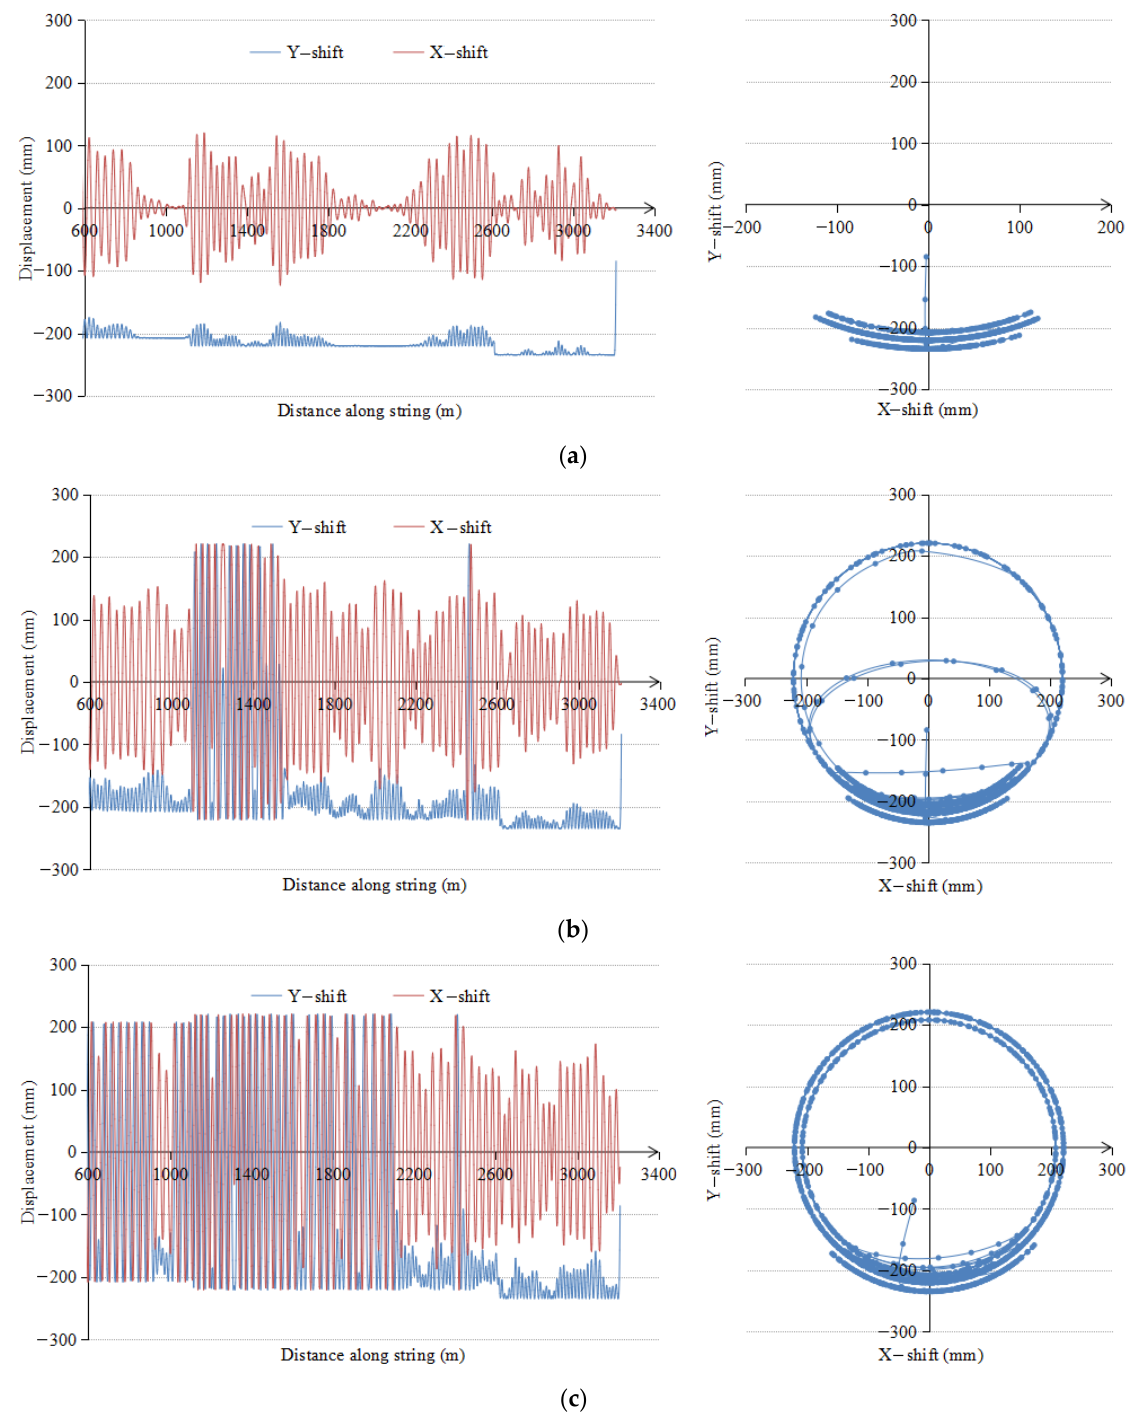
Figure 12. The spatial displacement distribution of DS. ( a ) The thrust force is 20T. ( b ) The thrust force is 30T. ( c ) The thrust force is 40T.